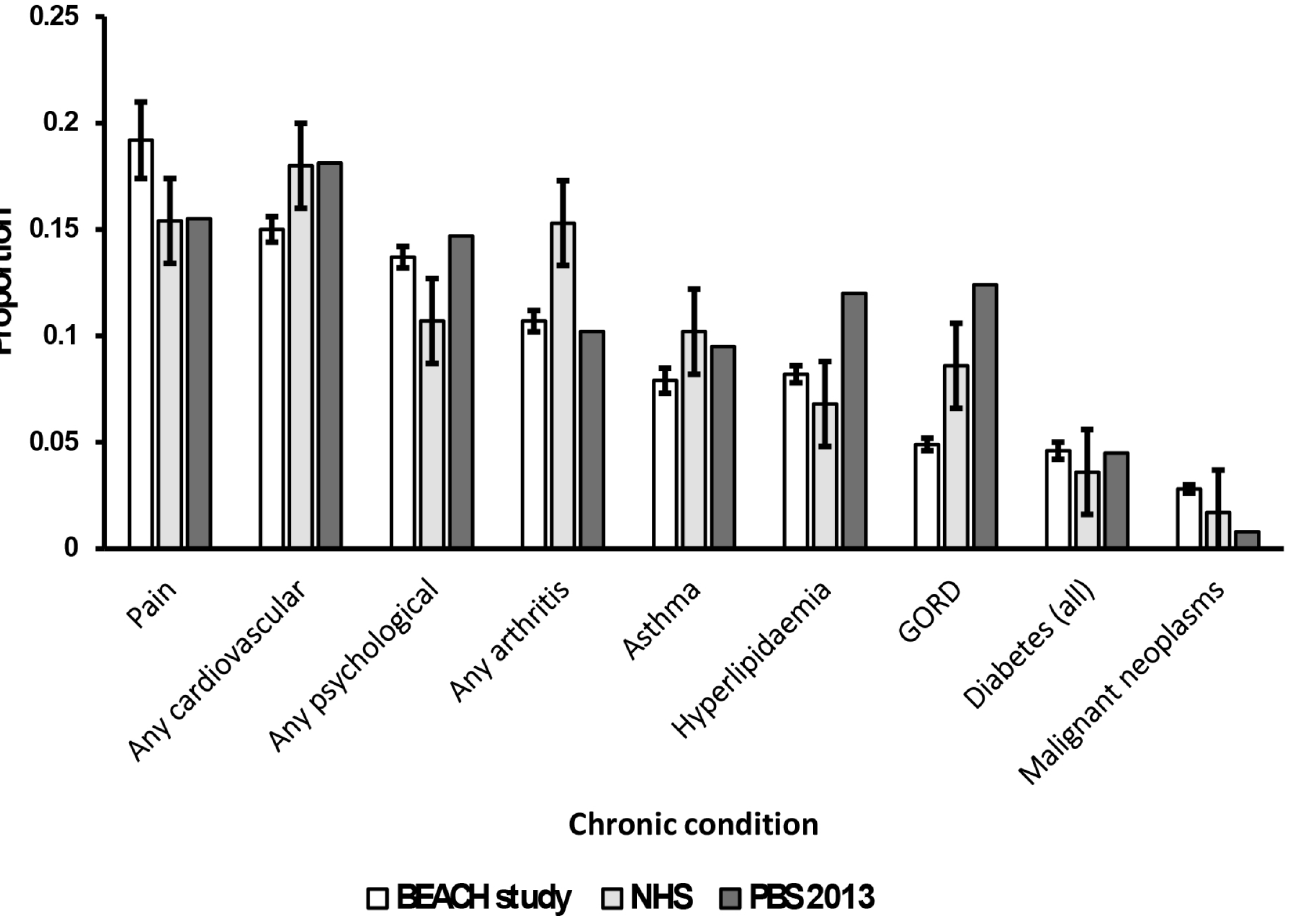
Figure 2: Comparison of chronic condition prevalence estimates (mean proportion, 95% CI) from the BEACH, NHS and PBS